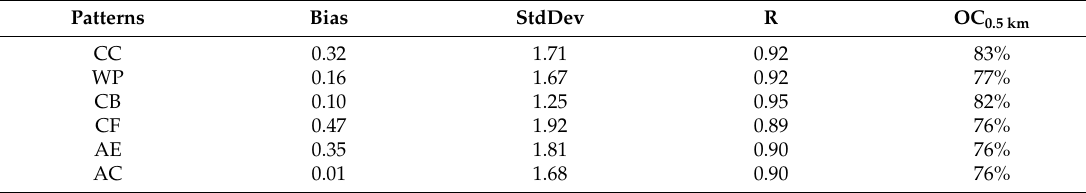
Table 2. Comparisons of cloud-top height retrieved from the radiosonde and ARSCL data under six synoptic patterns in terms of the mean bias (units in km), the standard deviation (StdDev; units in km), the correlation coefficient (R), and the occurrence frequency of the absolute differences of cloud top-heights less than 0.5 km for the two methods (OC 0.5 km